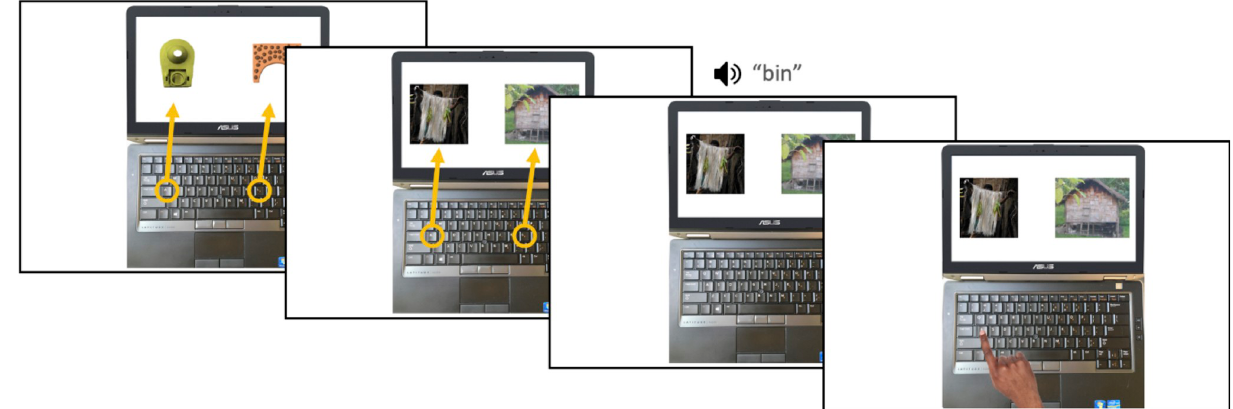
Fig 6. Example of the instructional slides preceding the practice test (left two slides) and a walkthrough trial (right two slides) showing participants how to pick the correct referent (grass skirt) for the Nungon word bin .